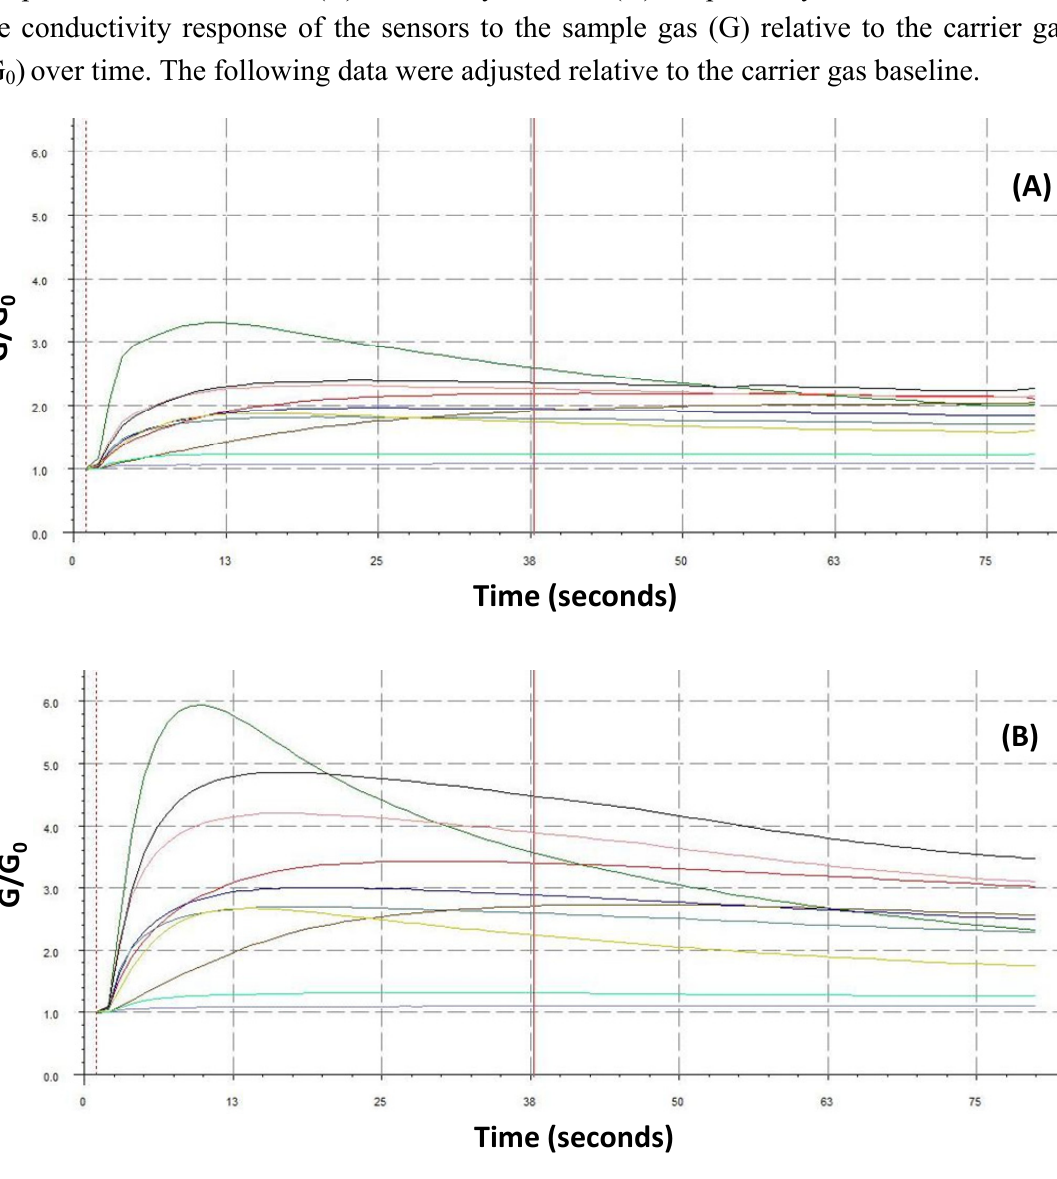
is the ratio of 0